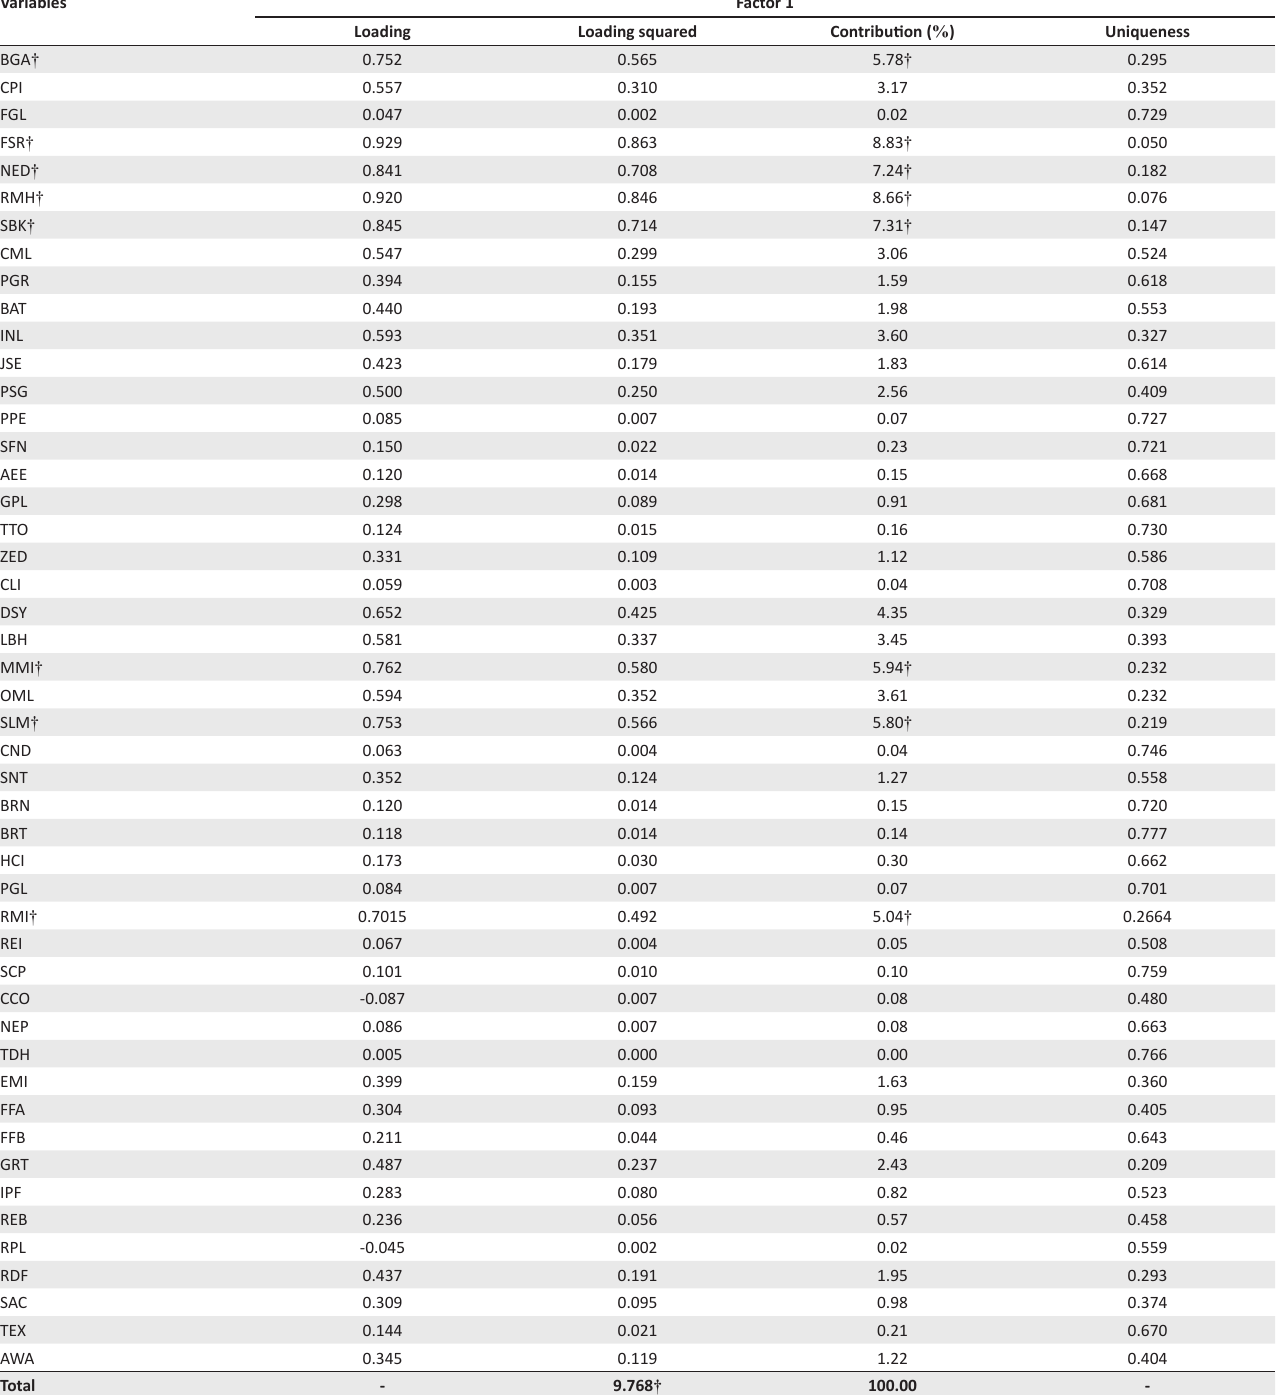
TABLE 3: Contribution to factor variance: Five -year time horizon.